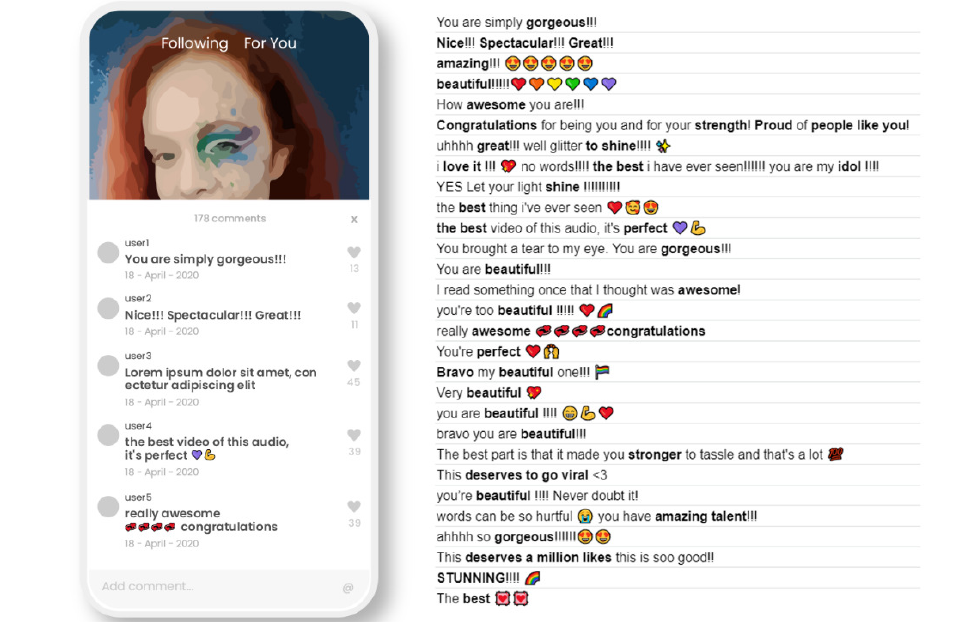
Figure 13. Top positive comments on